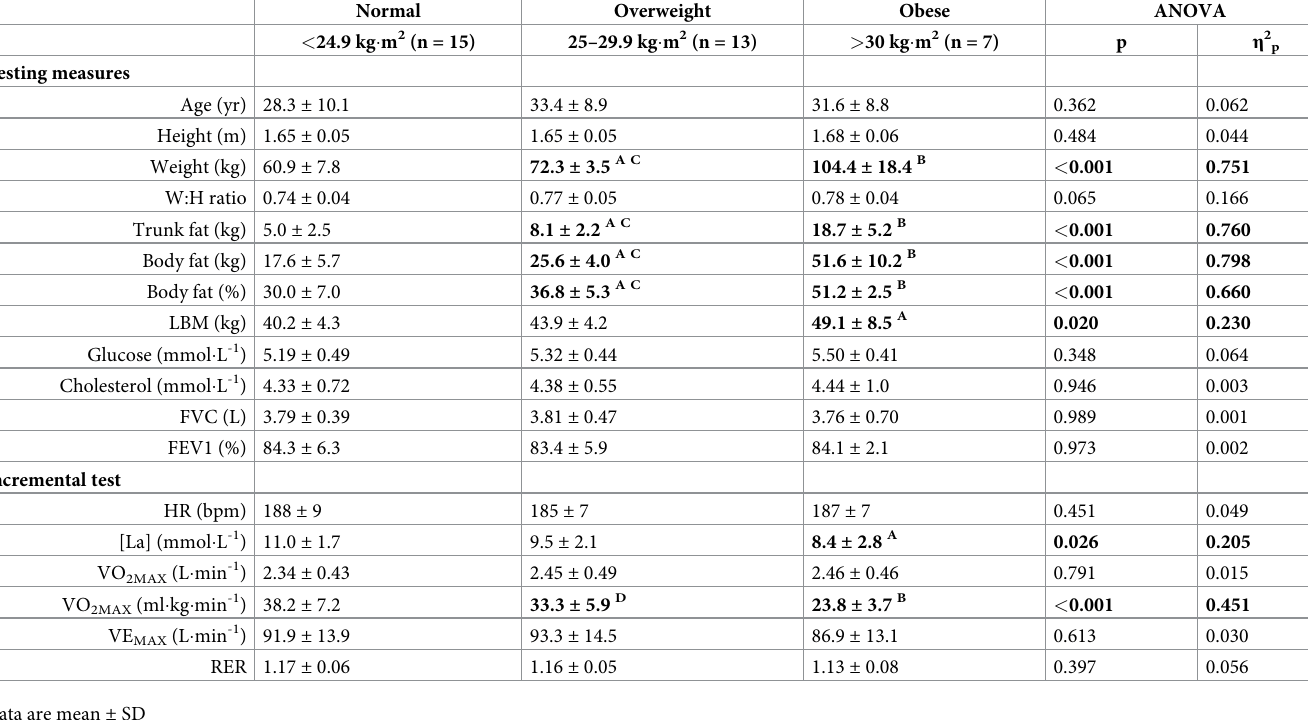
Table 1. Participants’ characteristics. Resting measures of anthropometry and spirometry, and maximum cardiorespiratory and blood lactate measures during the incre- mental test to exhaustion, of participants classified according to BMI groups. Normal Overweight Obese ANOVA < 24.9 kg � m 2 (n = 15) 25–29.9 kg � m 2 (n =